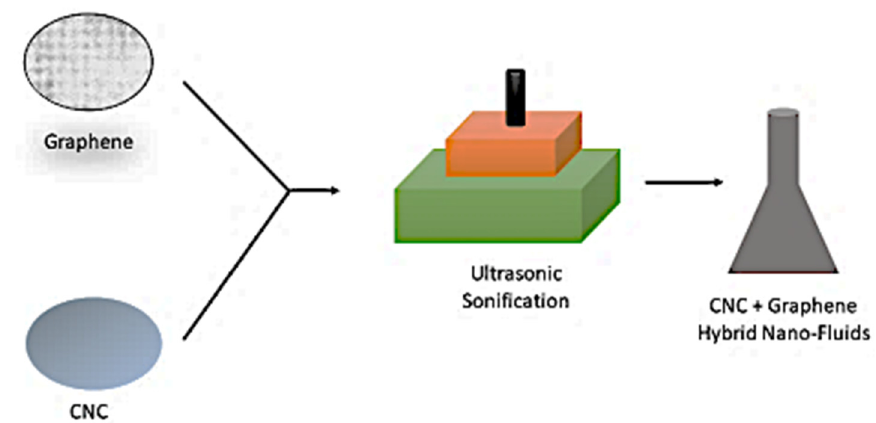
Figure 3. CNC nanofluids preparation process.